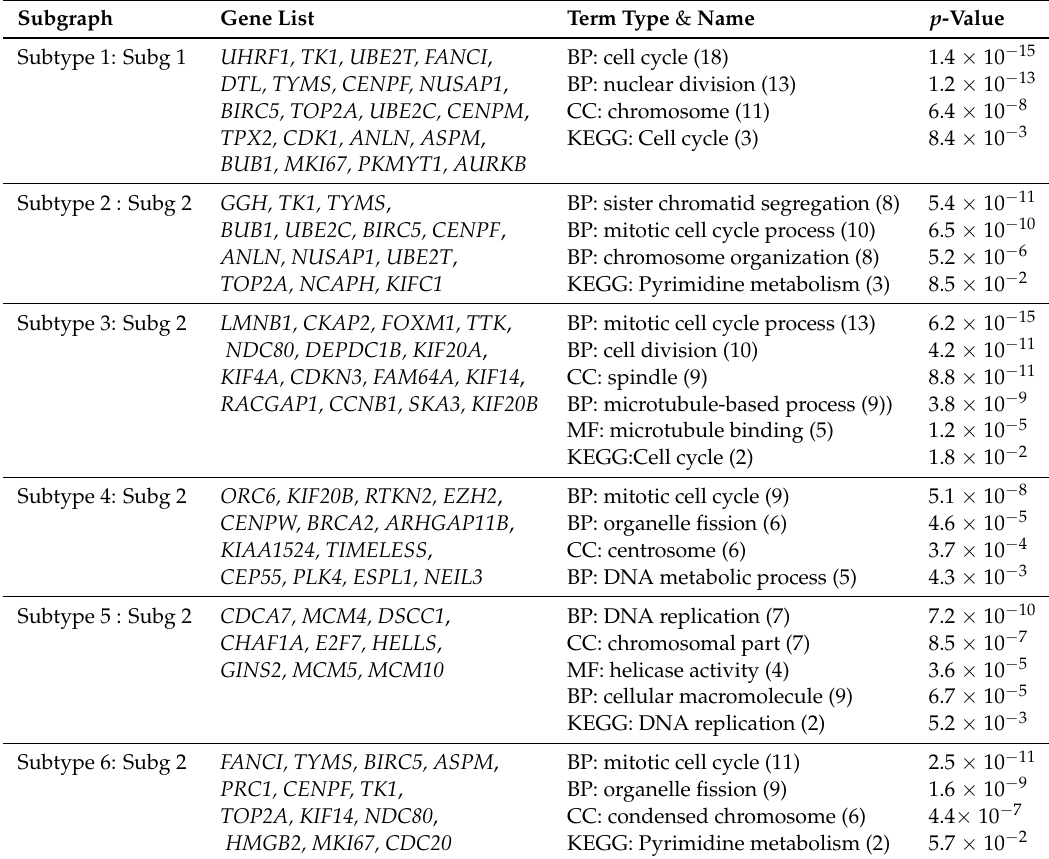
Table 4. Significant genes and Gene Ontology (GO) analysis of the co-expression networks of different melanoma